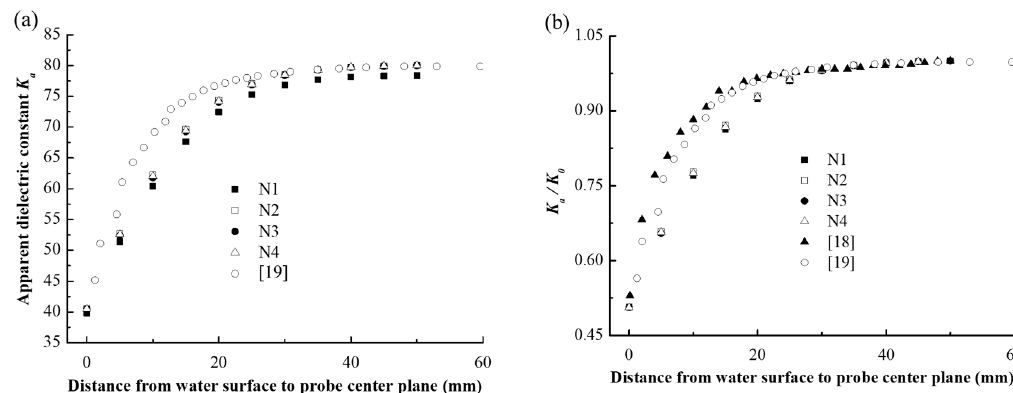
Figure 10. Comparison of computational and experimental results. ( a ) Apparent dielectric constant K a versus distance from water surface to probe center. ( b ) ratio of the apparent dielectric constant K a to the initial apparent dielectric constant K 0 versus the distance from the water surface to the probe center.